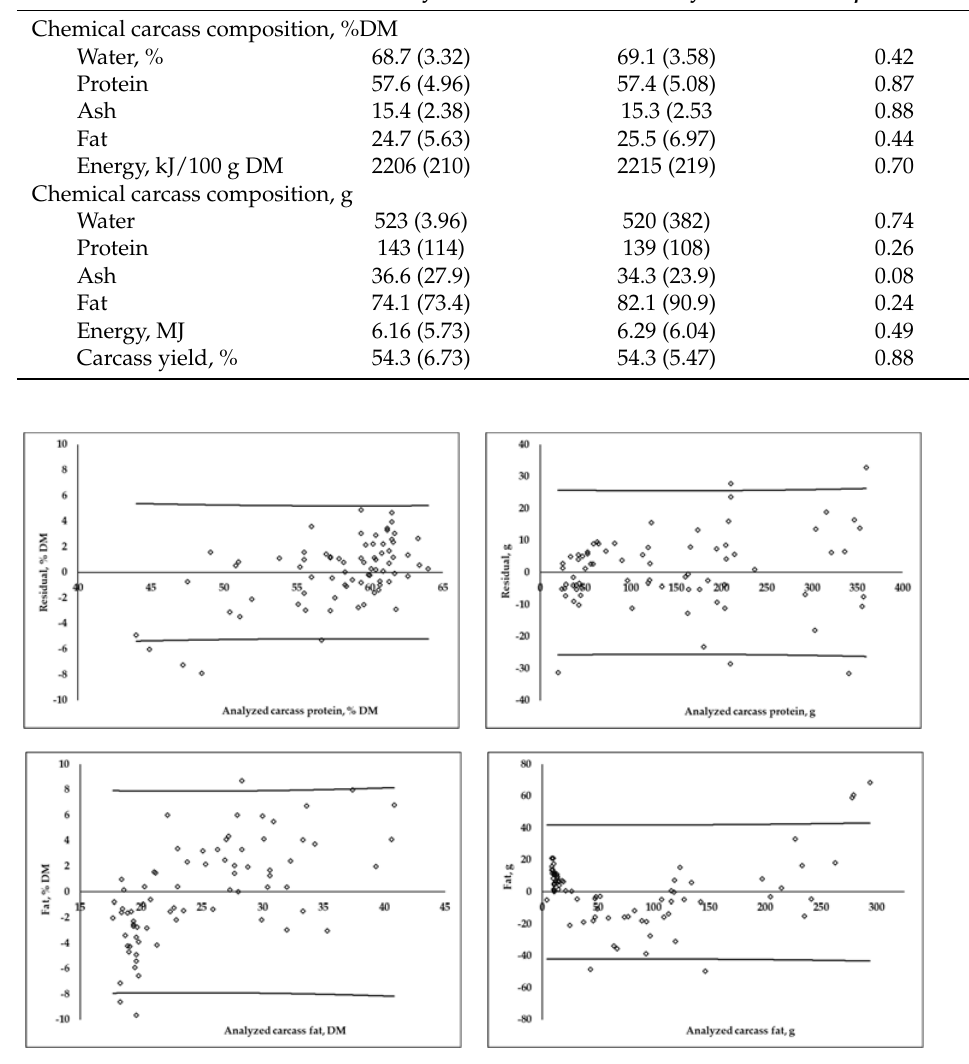
Figure 2. Residuals distribution (analyzed − predicted) of multiple linear regression equations for carcass protein and fat content, expressed as a DM percentage and in grams (calibration group; n = 75). Lines represent prediction confidence interval (95%).